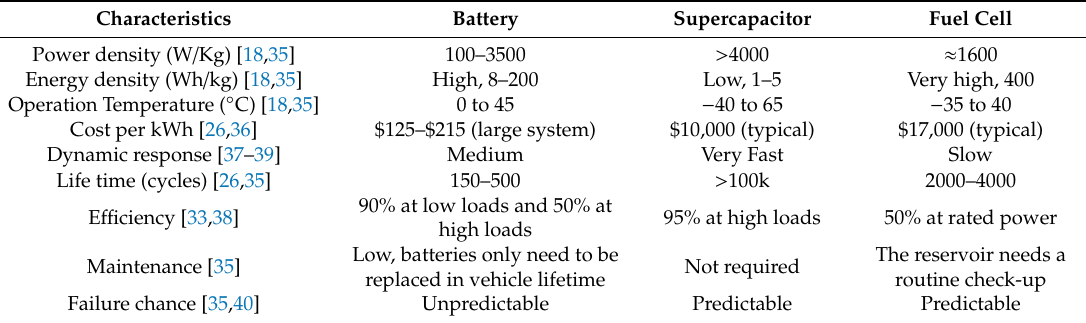
Table 2. Comparison of batteries, supercapacitors and fuel